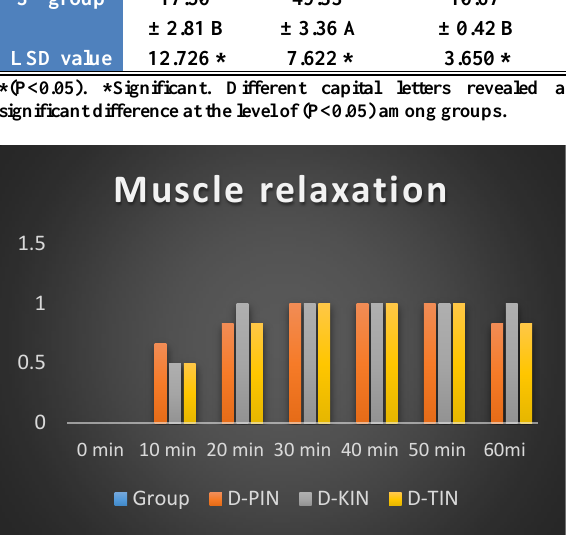
Figure, 1: Shows muscle relaxation in the three groups. Table, 2: shows evaluation of muscle relaxation. Time/